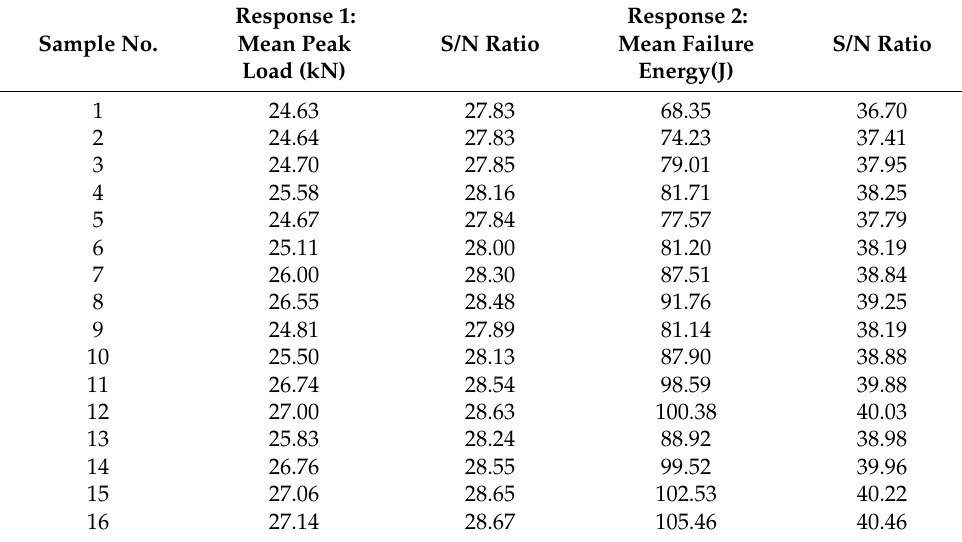
Table 5. Experimental results of response characteristics, i.e., mean peak load and mean failure energy with corresponding S/N ratios.